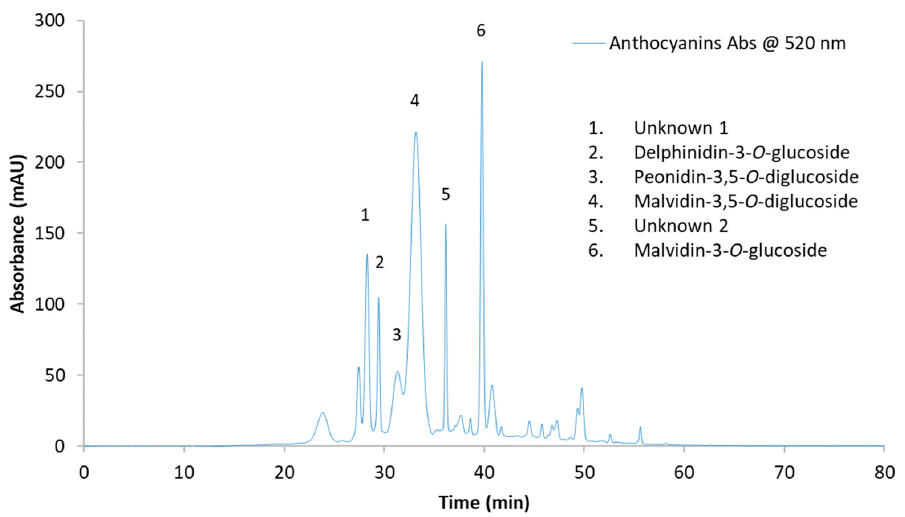
Figure 2. HPLC-DAD chromatogram at 520 nm of anthocyanins from CTL sample after aging. From left to right: unknown 1 (RT 28.287 min); delphinidin-3-O-glucoside (RT 29.448 min); peonidin-3,5-O-diglucoside (RT 31.330 min); malvidin-3,5-O-diglucoside (RT 33.175 min); unknown 2 (RT 36.153 min); malvidin-3-O-glucoside (RT 39.772). Table 2. Monomeric anthocyanins content (mg/L) in Marquette grape musts and wines at crushing, bottling, and after 5 months aging. Values are mean ± standard deviation ( n = 2).